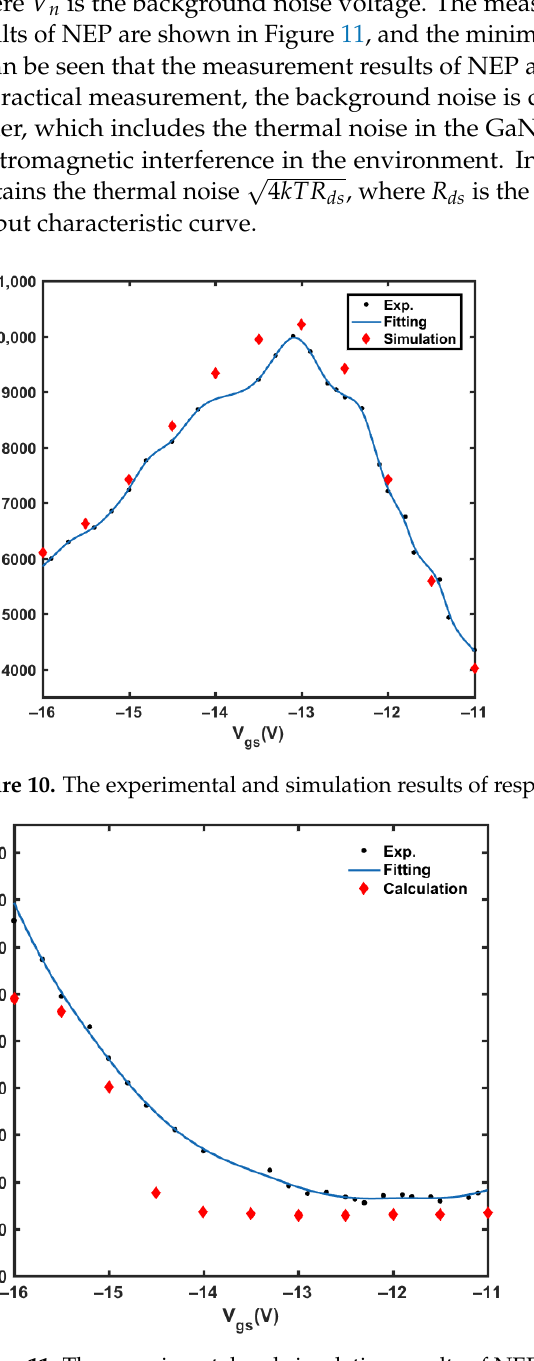
Figure 11. The experimental and simulation results of NEP with the change of V gs .